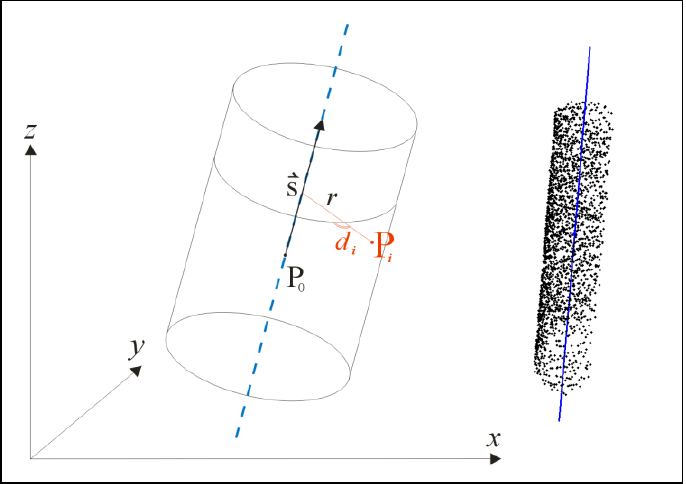
Figure 6. Cylinder parameters, determined in the adjustment process (left) and one example of the results in MATLAB, showing the estimated cylinder axis (right; only every 100th point is drawn).